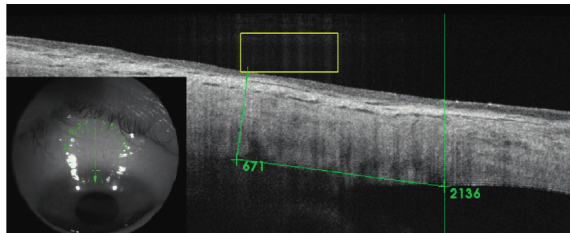
Figure 3: OCTscan of a patient before UCP—distance from limbus to the point where sclera and conjunctiva thickness measurements should be taken (2136 μ m) was derived from the scan obtained after the procedure (Figure